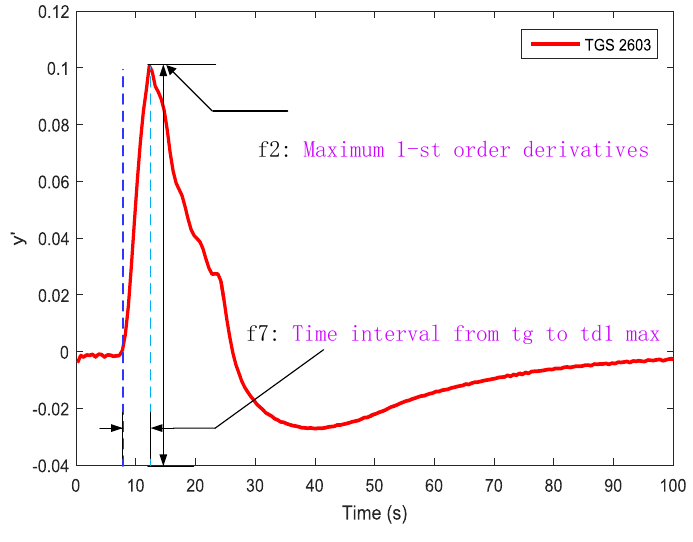
Figure 4. Feature 2 and 7 extracted from the 1st-order derivative-based sensor response